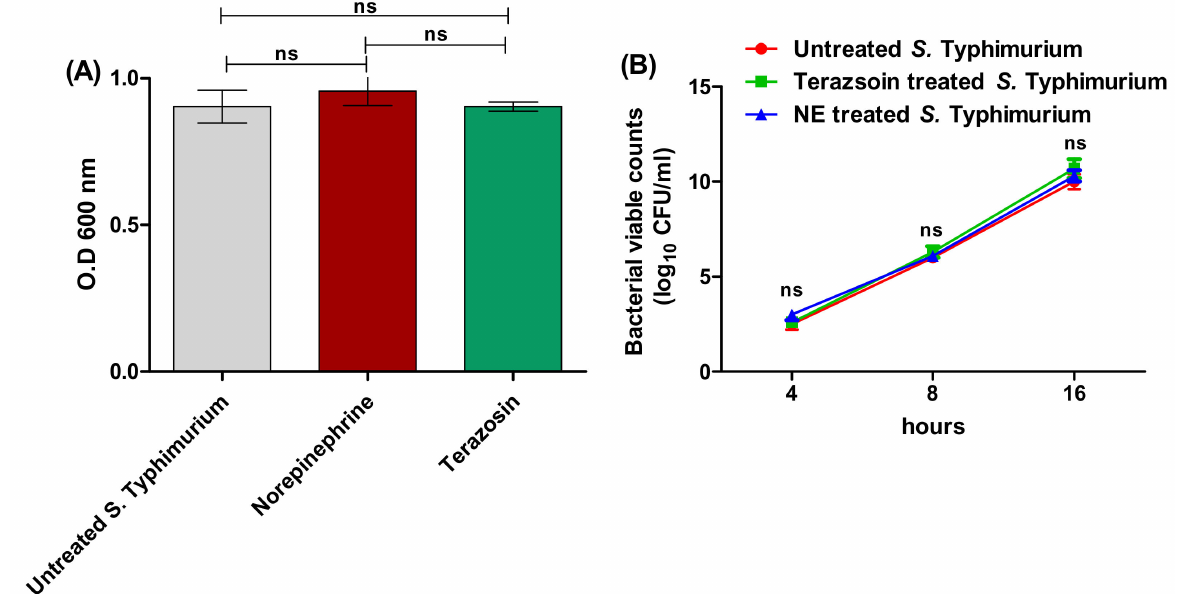
Figure 1. The effect of terazosin at the sub-MIC and norepinephrine on S. Typhimurium growth. ( A ) There was no significant difference between the O.D of S. Typhimurium growth in the presence of norepinephrine (50 µ g/mL) or terazosin (sub-MIC) and the O.D of untreated bacterial growth after 24 h. ( B ) Viable counting of terazosin-treated, NE-treated, or untreated control S. Typhimurium cultures at different time periods (after 4 h, 8 h, and 16 h). Neither terazosin nor NE showed a statistical inhibitory effect on S. Typhimurium growth. The experiment was repeated in triplicate, and the data are presented as the mean ± the SD. A one-way ANOVA test, followed by Tukey’s multiple comparison post-hoc test, was employed to attest the statistical significance; p < 0.05 was considered